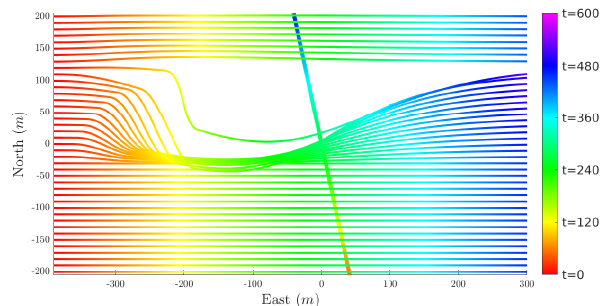
Table 2: Non rule-based parameters.